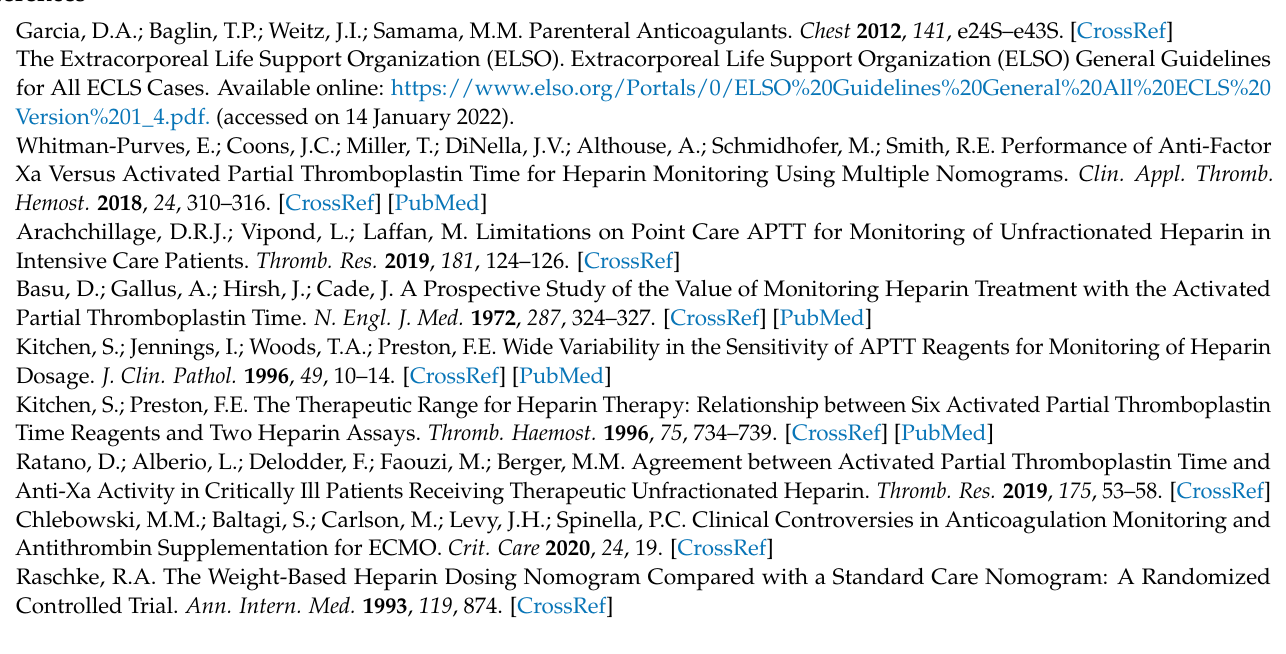
Table S2: Results of the final multivariable model; Table S3: Comparison of the different tests used to monitor unfractionated heparin